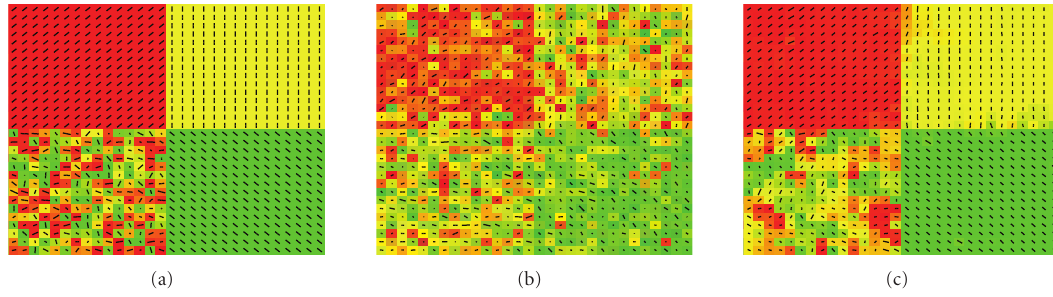
Figure 4: Visualization of (a) the true vector field, (b) the noisy field, and (c) the recovered field. In this example, the tensor field is isotropic in the lower-left corner, anisotropic in the other parts.